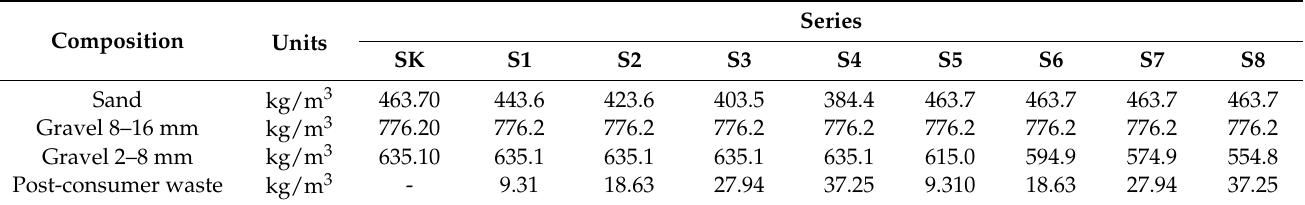
Table 1. Composition of the mixture of control concrete and waste-modified concretes as a substi- tute for sand and gravel aggregate of grain size 2–8 mm.